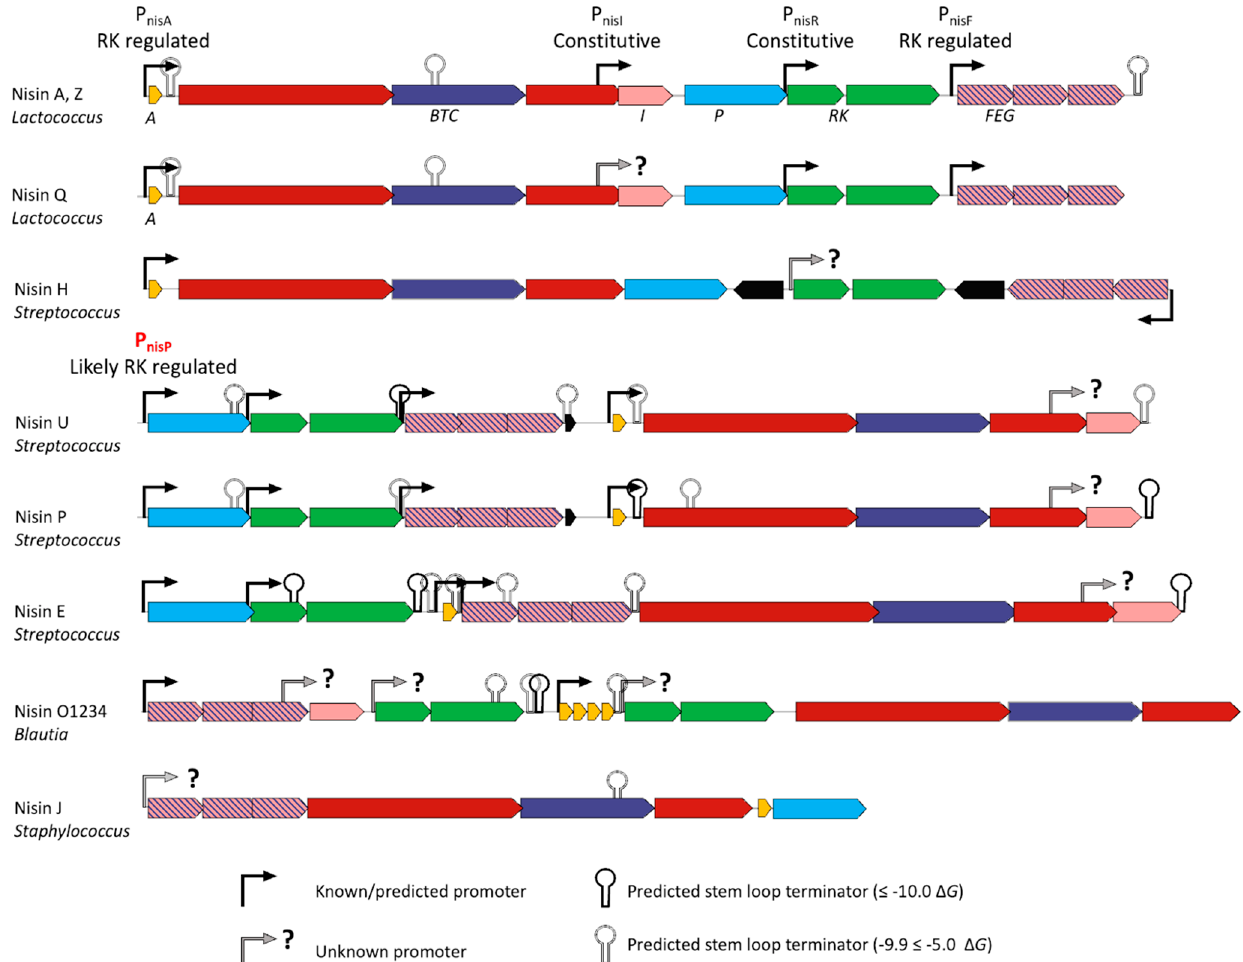
Figure 4. Predicted promoters of nisin variant production operons. Absent promoter sequences are denoted by arrows with question marks. Rho-independent transcription terminators of the forward strand with a free Gibbs energy ( Δ G ) lower than − 5.0 kcal/mol are denoted by stem loop structures, predicted by ARNold.